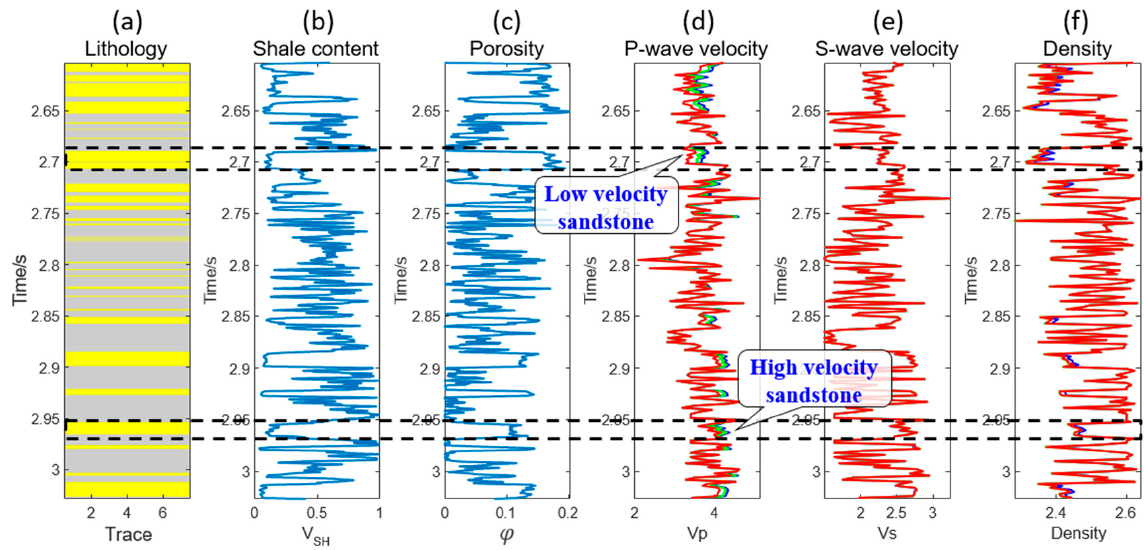
Figure 11. Physical property and elastic parameter logging curves: ( a ) lithology, ( b ) shale content, ( c ) porosity, ( d ) P-wave velocity, ( e ) S-wave velocity, and ( f ) density.